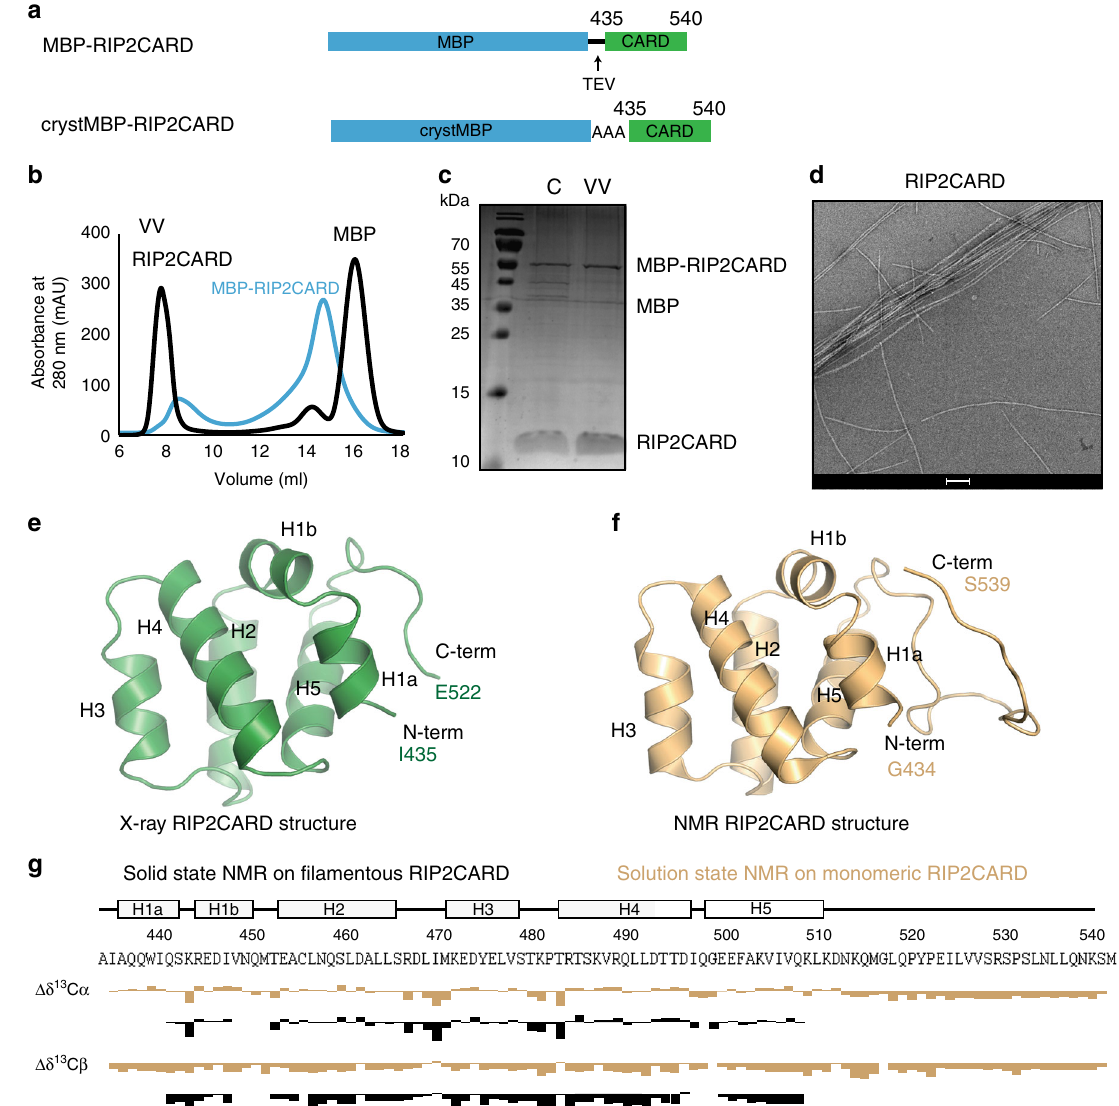
Fig. 3 Structure of monomeric RIP2CARD. a Domain organization of MBP-RIP2CARD constructs used for expression and puri fi cation of recombinant RIP2CARD from E . coli Rosetta 2. MBP-RIP2CARD was used for characterising the polymerization ability of the CARD domain and for NMR experiments. CrystMBP-RIP2CARD was used for crystallization. b Typical size exclusion chromatography pro fi les of RIP2CARD puri fi cation showing both tagged (blue) and tag-free RIP2CARD (black). c 17 % SDS-PAGE showing typical sample obtained from RIP2CARD puri fi cation. The SDS-PAGE indicates that tag cleavage by TEV is incomplete. d Negative-stain electron micrograph of RIP2CARD VV. Scale bar is 100 nm. e Ribbon diagram of the RIP2CARD crystal structure reported in this paper f Ribbon diagram of the solution NMR structure of RIP2CARD (PDB: 2N7Z). g Comparison of secondary chemical shifts of RIP2CARD as a monomer in solution (yellow; BMRB entry: 25828) and in the fi lament, determined by proton-detected solid-state NMR (black). Experimental 13 C α and 13 C β chemical shifts were subtracted from the respective random coil values for each amino acid type ( Δδ C α , Δδ C β ) 79,80 . C: sample after tag cleavage as loaded on size-exclusion chromatography, VV: size exclusion chromatography void